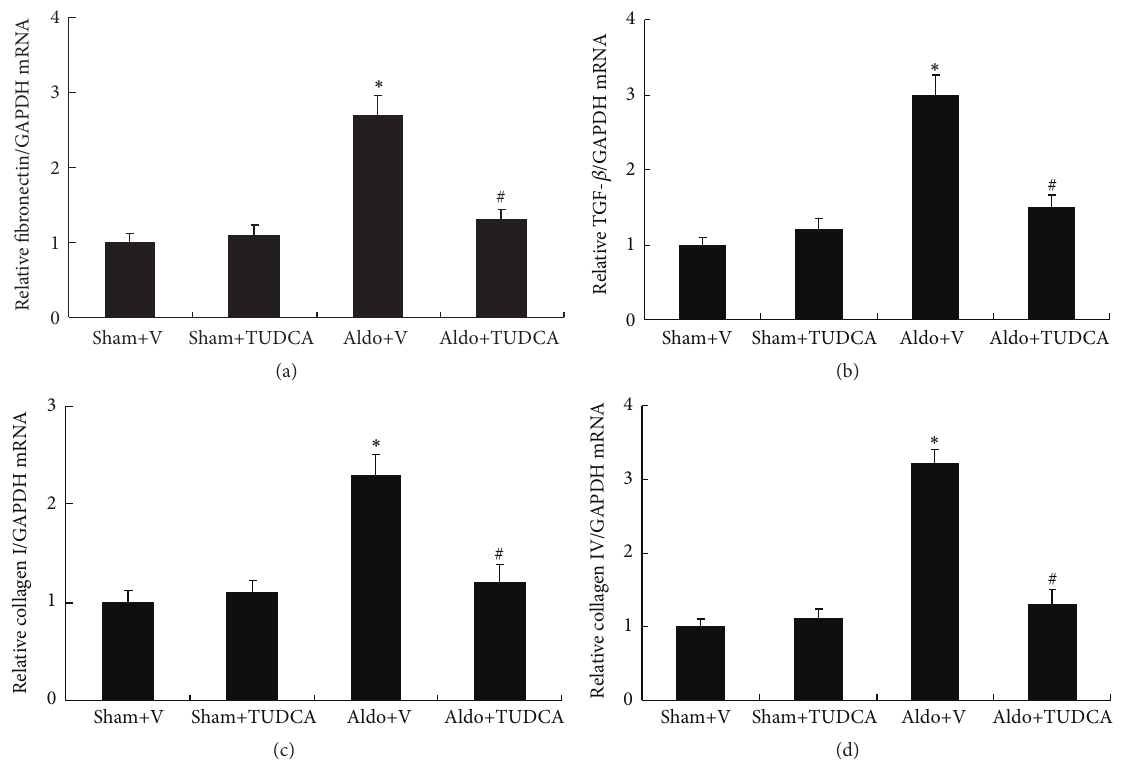
Figure 2: Expression of fibrotic cytokines in the kidney. (a) mRNA expression of fibronectin, (b) TGF- 𝛽 , (c) collagen I, and (d) collagen IV was detected by real-time PCR and normalized to expression of glyceraldehyde 3-phosphate dehydrogenase. Values are mean ± SEM ( 𝑛 = 6 ). ∗ 𝑝 < 0.05 , Sham+V group versus Aldo+V group, # 𝑝 < 0.05 , Aldo+V group versus Aldo+TUDCA